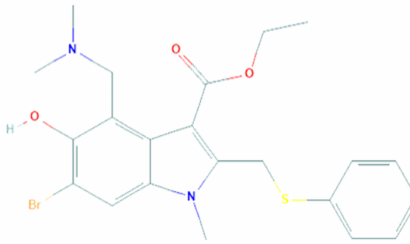
Figure 1. Chemical structure of